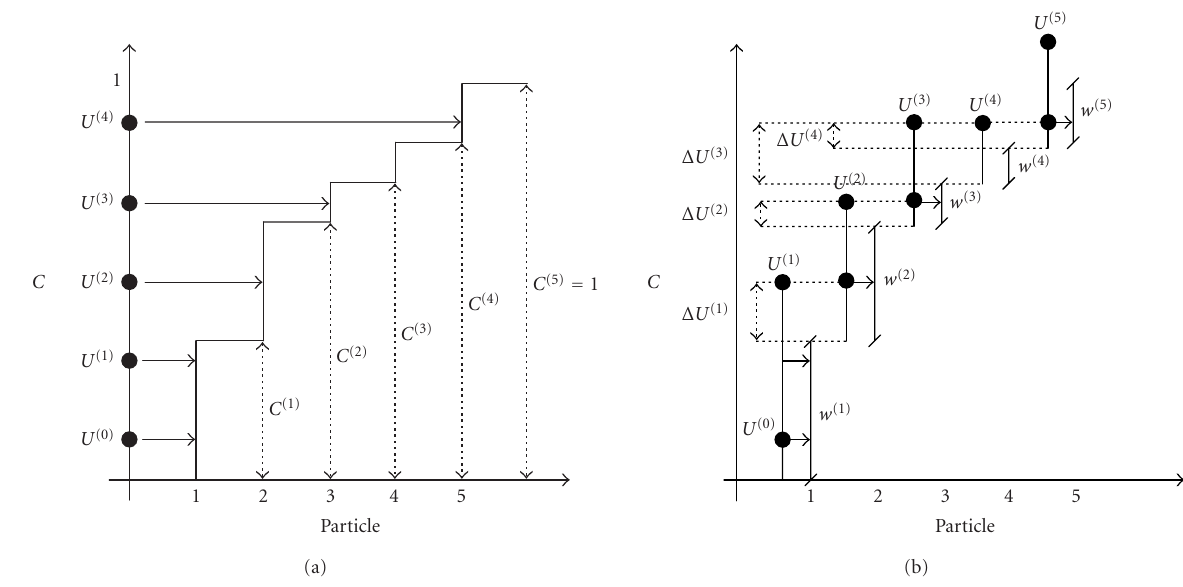
Figure 1: (a) Systematic and (b) residual systematic resampling for an example with M = 5 particles.